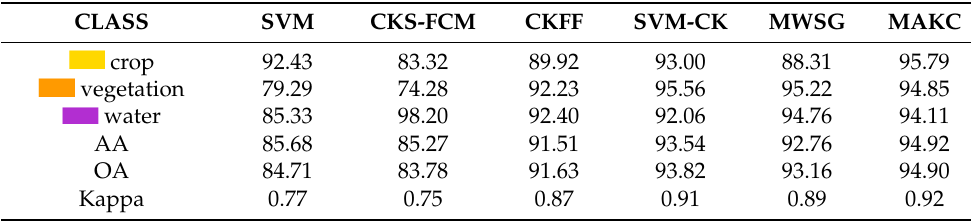
Table 4. Classification precision results on